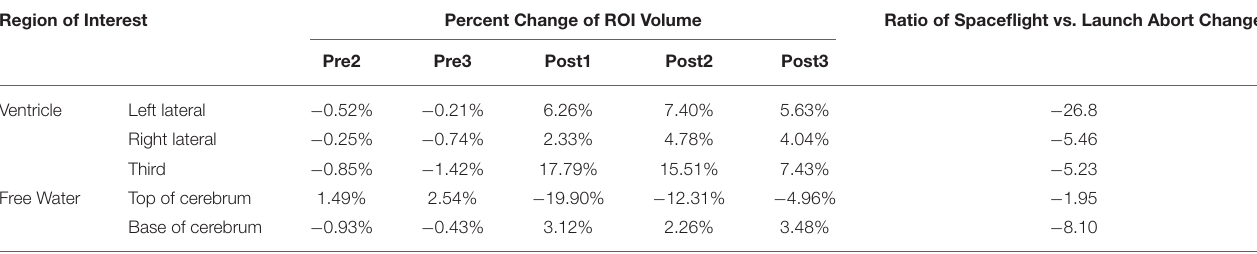
TABLE 2 | CAL’s percent change in ROI volume at each session relative to the baseline Pre1 session. Region of Interest Percent Change of ROI Volume Ratio of Spaceflight vs. Launch Abort Change Pre2 Pre3 Post1 Post2 Post3